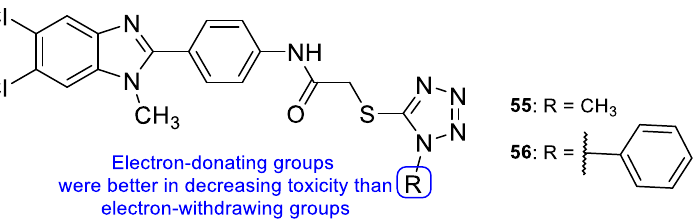
Figure 30. Chemical structures of compounds 55 and 56 , and toxicity SAR [110].